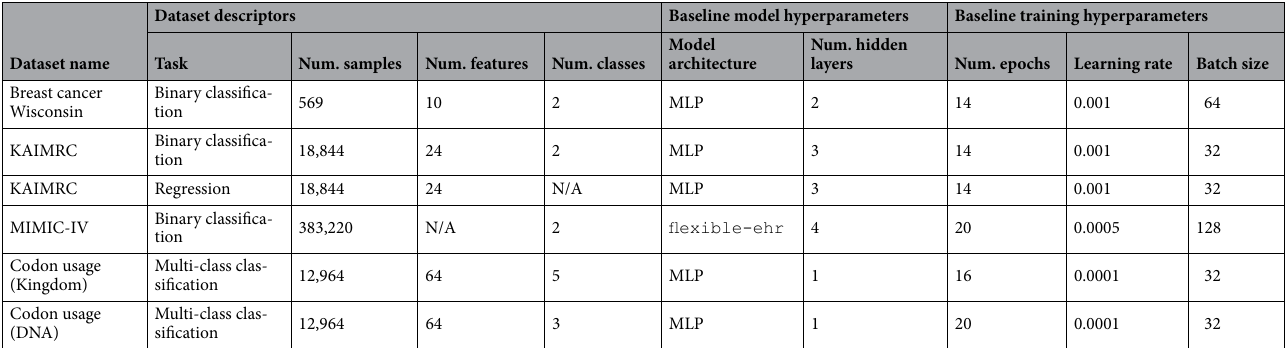
Table 1. Summary of the dataset and tasks used to evaluate Deep Explanation Ensembles alongside baseline model and training hyperparameters. Note that MIMI-IV is a time-series dataset and so each entry will have different numbers of features, and the KAIMRC (Regression) task has no target class as it is a regression